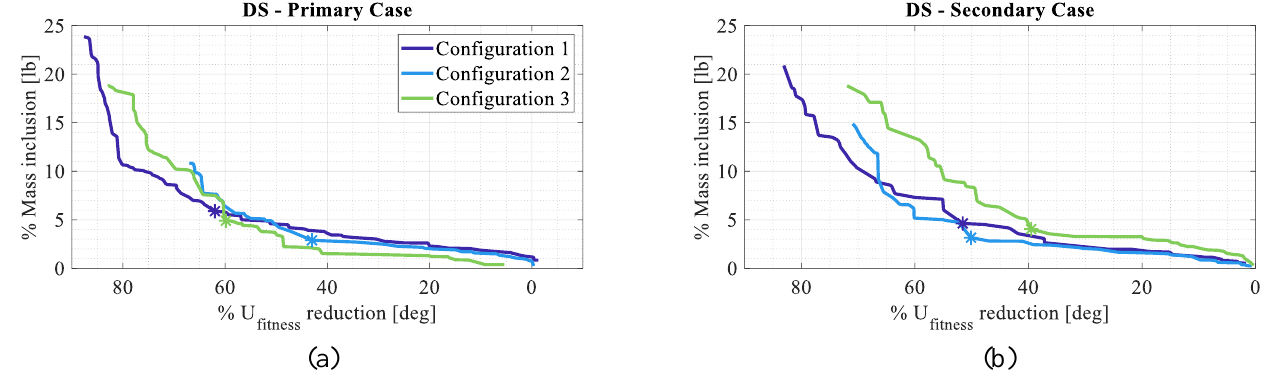
Figure 10. Comparison of Pareto fronts between all configurations investigated in the study for both the ( a ) primary and ( b ) secondary operational scenarios modelled with the PSD.